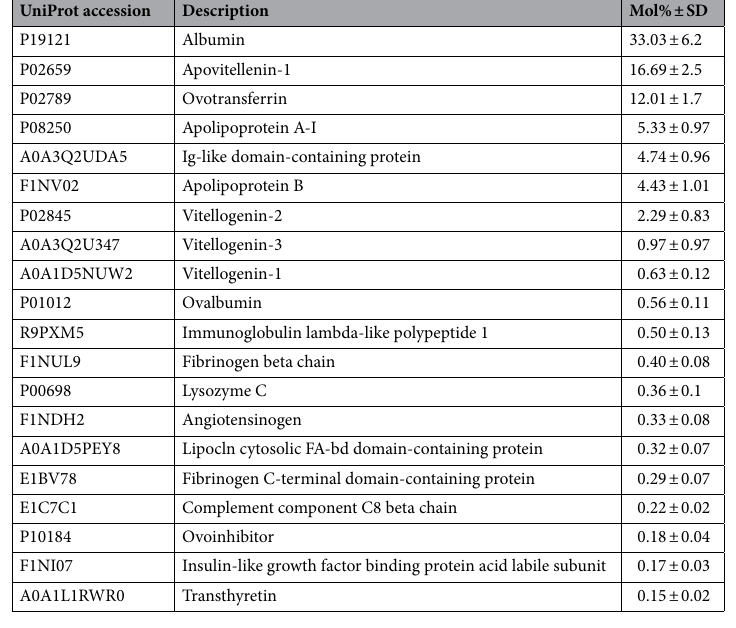
Table 2. Top 20 proteins detected in